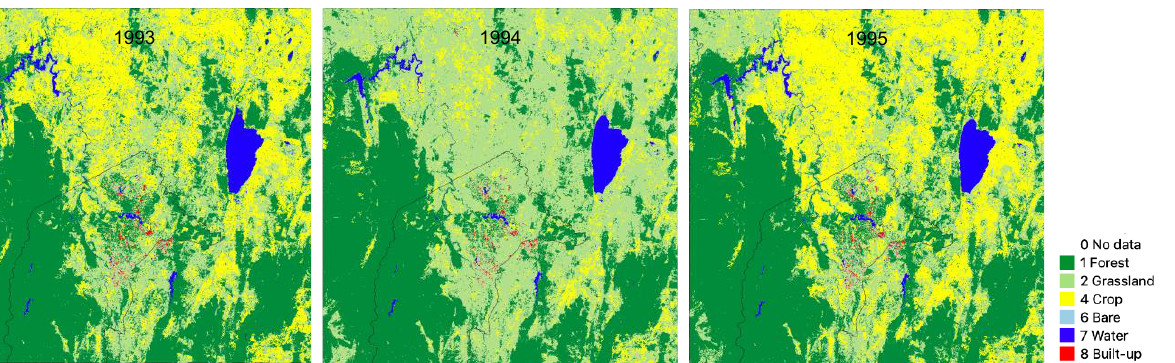
Figure 10. Temporal instability of Crop unit (yellow), derived from Cultivated Terrestrial Vegetated: Herbaceous, in simplified DEA Land Cover for 1993–1995.